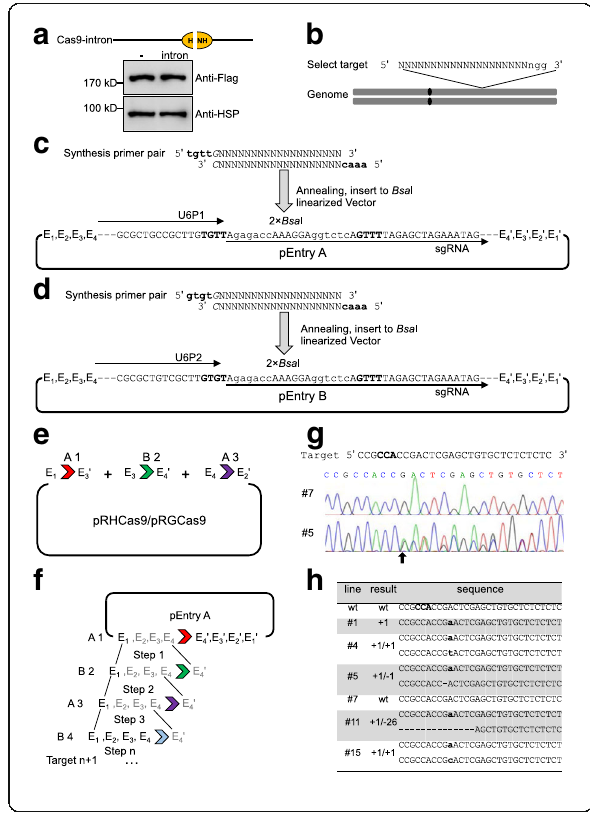
contained some errors. The updated Table S1 is published in this correction article.